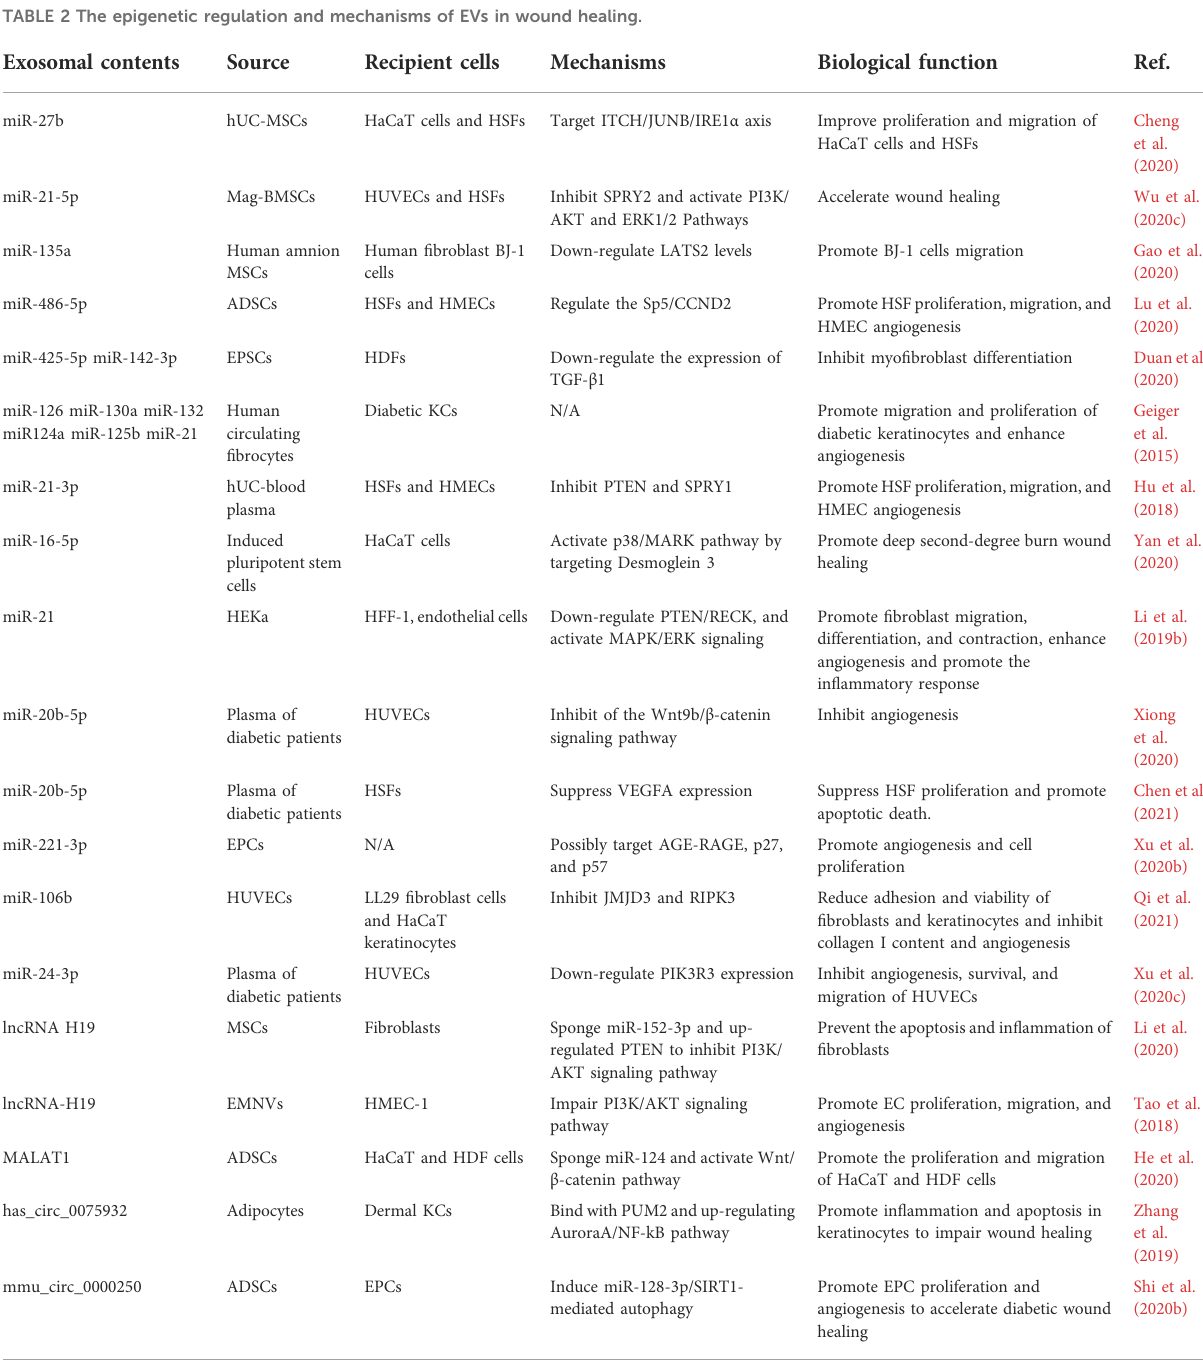
TABLE 2 The epigenetic regulation and mechanisms of EVs in wound